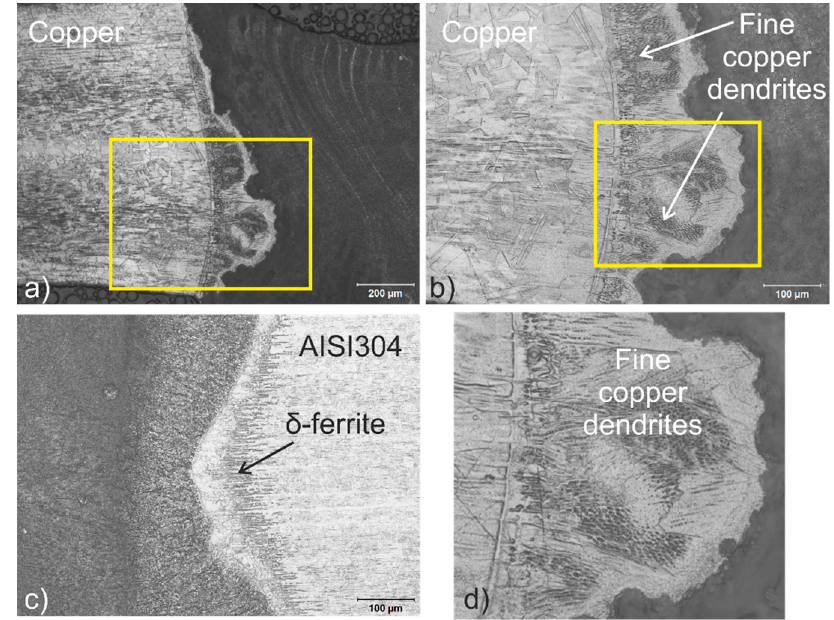
Figure 6. ( a ) Copper-HAZ-weld metal transition of weld No. 5; ( b ) higher magnification of copper-weld metal interface; ( c ) weld metal-AISI 304 HAZ interface, ( d ) fine copper dendrites zone at higher magnification.